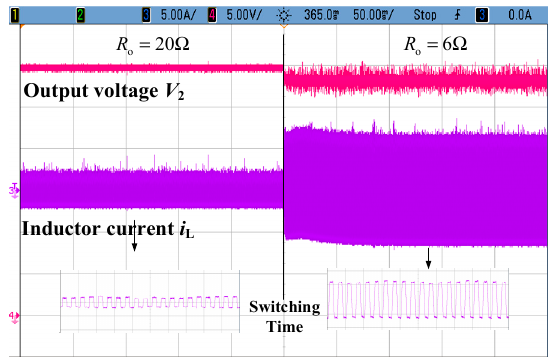
Figure 16. State variables under the model predictive control with the load change when k = 0.65.